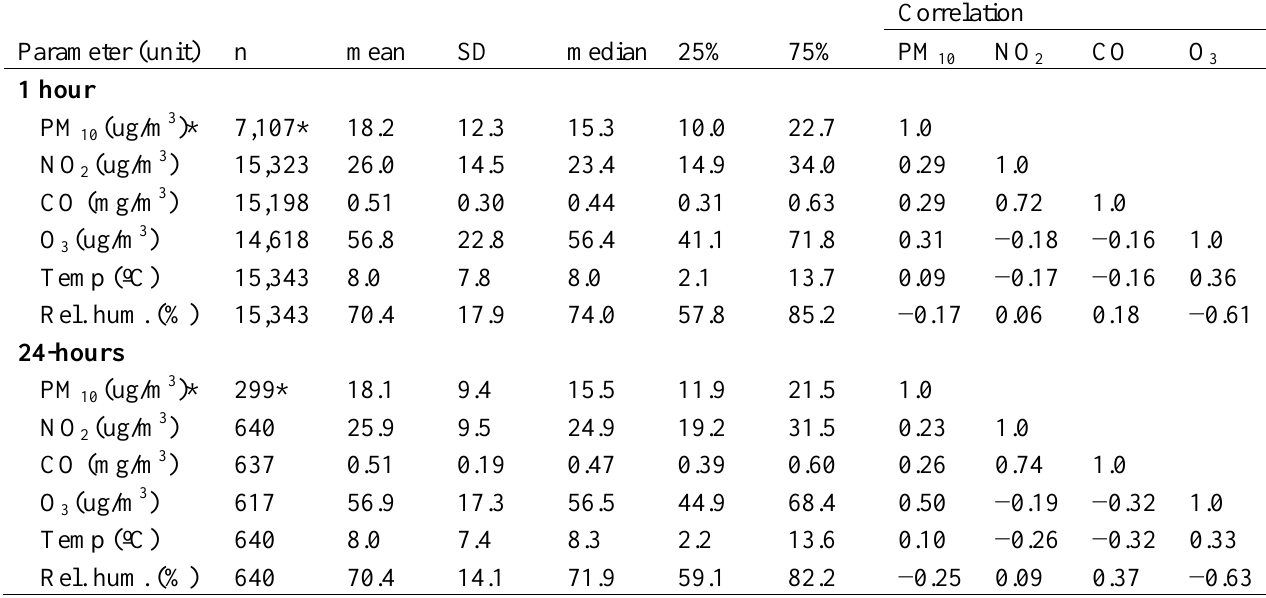
Table shows n / N (%) except for age in years. Table 2. Hourly and daily distribution of air pollution and meteorology parameters in Stockholm, April 1993 to December 1994.